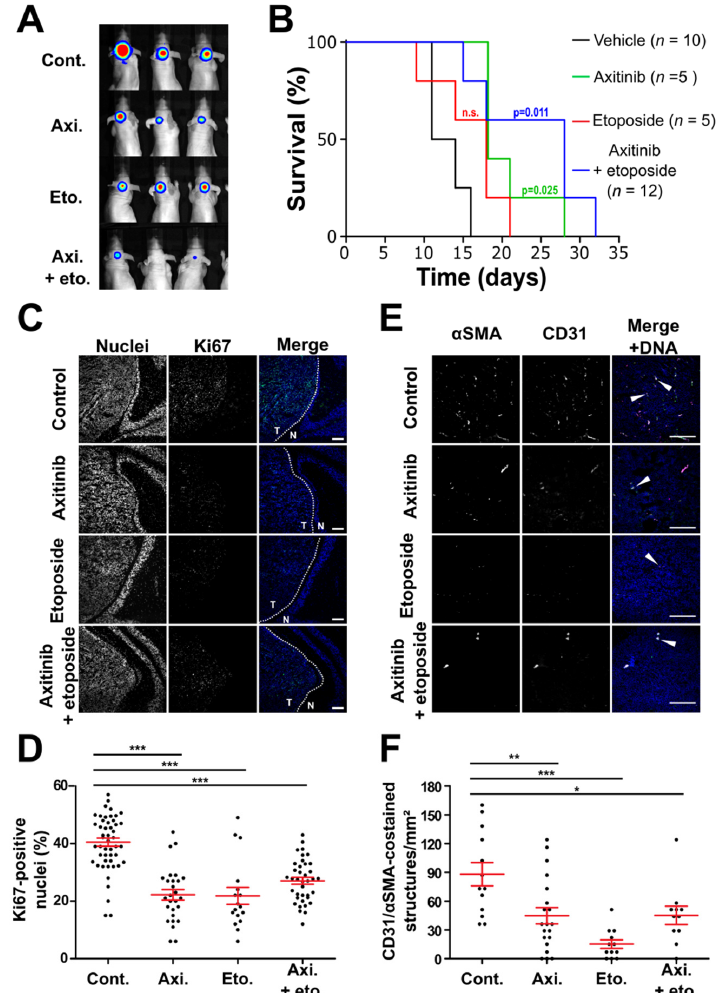
Figure 4. Axitinib and axitinib/etoposide combination reduce the HD-MB03 intracranial tumor growth rate and increase survival more efficiently than etoposide. ( A ) Representative picture of the BLI signal intensity after 11 days of treatment. ( B ) Survival curves presenting the proportion of alive mice as a function of time after tumor implantation (black: control treatment; green: axitinib treatment; red: etoposide treatment; blue: axitinib/etoposide combined treatment; the p -value of a logrank test comparing the control and the axitinib or axitinib/etoposide groups is indicated with a relevant color; all the other comparisons were not statistically significant; the total number of animals for each group is indicated in brackets). ( C ) Images of sections of HD-MB03 intracranial tumors treated with the indicated compounds. Proliferative cells are revealed by nuclear Ki67 immunofluorescent staining (green) and Hoechst33342 DNA counterstaining (blue). Dotted lines delineate the border between normal (N) and tumoral (T) tissues (scale bars: 200 µm). ( D ) Dot plot representing the quantification of the proportion of Ki67-positive nuclei (*** p < 0.001, one-way ANOVA test, at least four independent tumors were analyzed). ( E ) Images of sections of HD-MB03 orthotopic tumors treated with the indicated compounds. The vasculature is revealed by CD31 and α SMA immunofluorescent staining (green and magenta, respectively) and Hoechst33342 nuclear DNA counterstaining (blue) (scale bars: 100 µm). ( F ) Dot plot representing the number of functional blood vessels per mm² in the indicated experimental conditions (bars represent the means ± SEM; *** p < 0.001, ** p < 0.01, * p < 0.05, one-way ANOVA test, at least four independent tumors were analyzed).